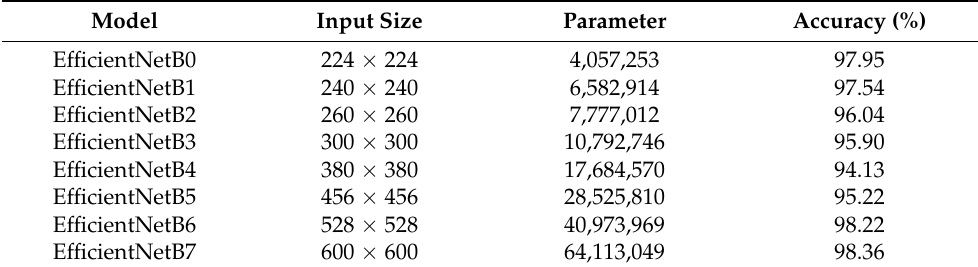
Table 1. Comparison of different EfficientNet